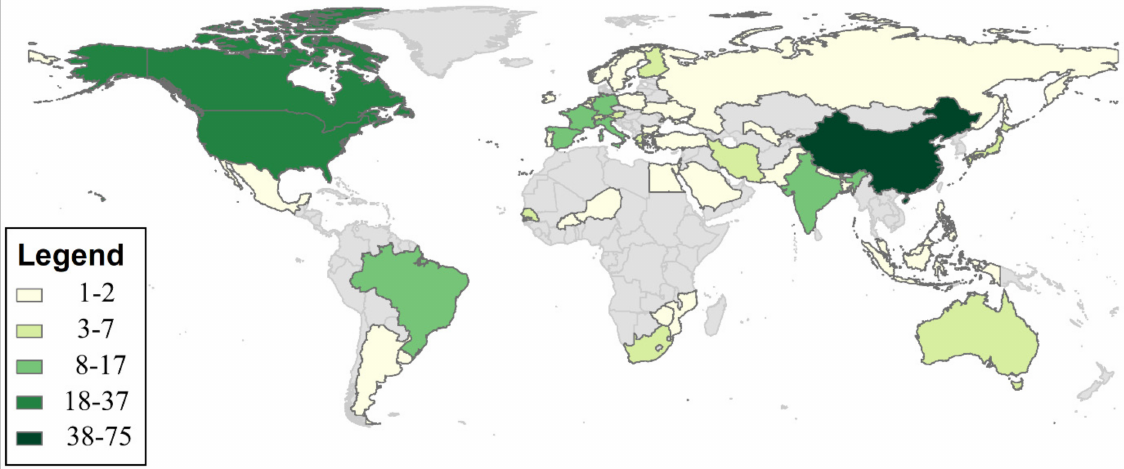
Figure 5. World map illustrating the number of published articles based on the location of the study site.